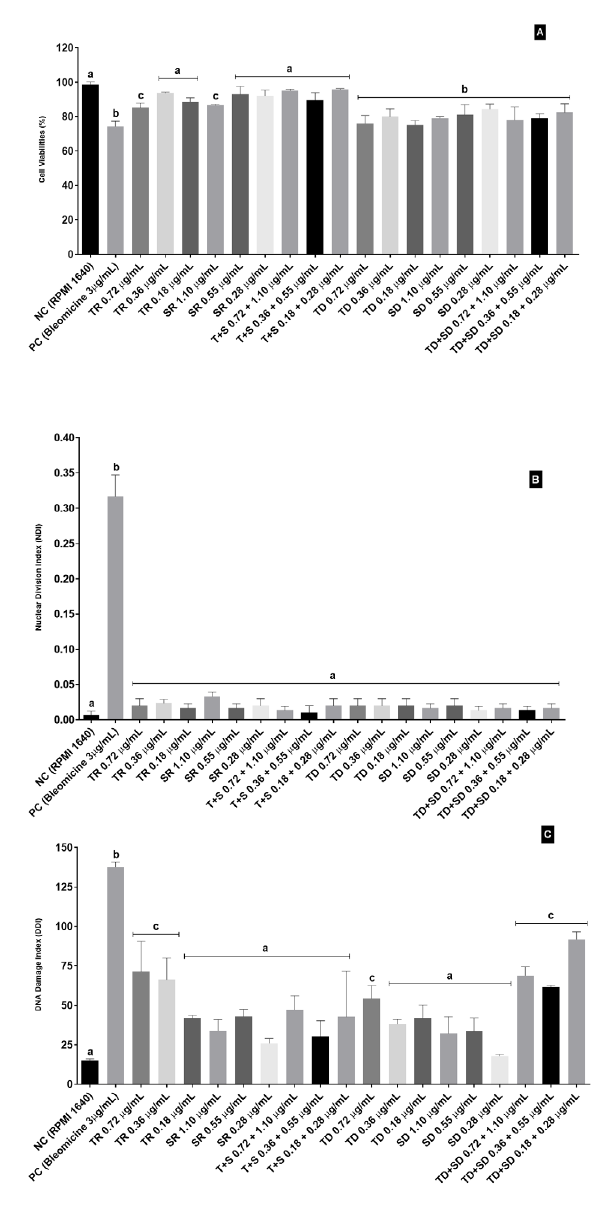
FIGURE 4 - A – Evaluation of leukocyte viability by Trypan blue exclusion test; B – Effects on cell division index; C – DNA Damage Index of exposed cells. Evaluation after exposure to TAD and SIL in their isolated, associated, not degrade, and photodegraded forms. Acronyms: Associated and not degraded (T+S); photodegraded TAD (TD), photodegraded SIL (SD), nondegraded TAD (TR), nondegraded SIL (SR), TAD and SIL associated and photodegraded (TD+SD), negative control (NC), positive control (PC). Different letters (a, b, c) indicate a statistically significant